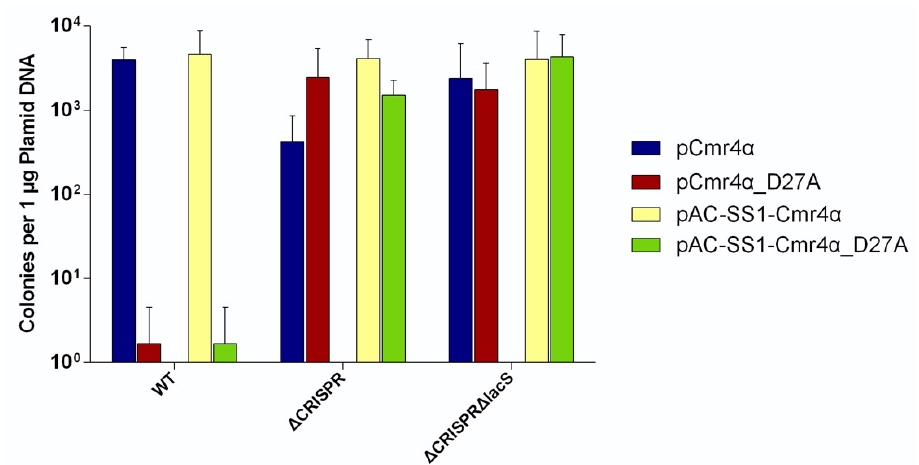
Figure 3. Contribution of CRISPR array and target sequence to the Cmr4 α -D27A toxicity. Transformation efficiency was determined for pCmr4 α and pCmr4 α -D27A plasmids individually with three different host strains: ∆β E233(WT), ∆ CRISPR ∆β and ∆ CRISPR Δ lacS ∆β ( ∆ array).